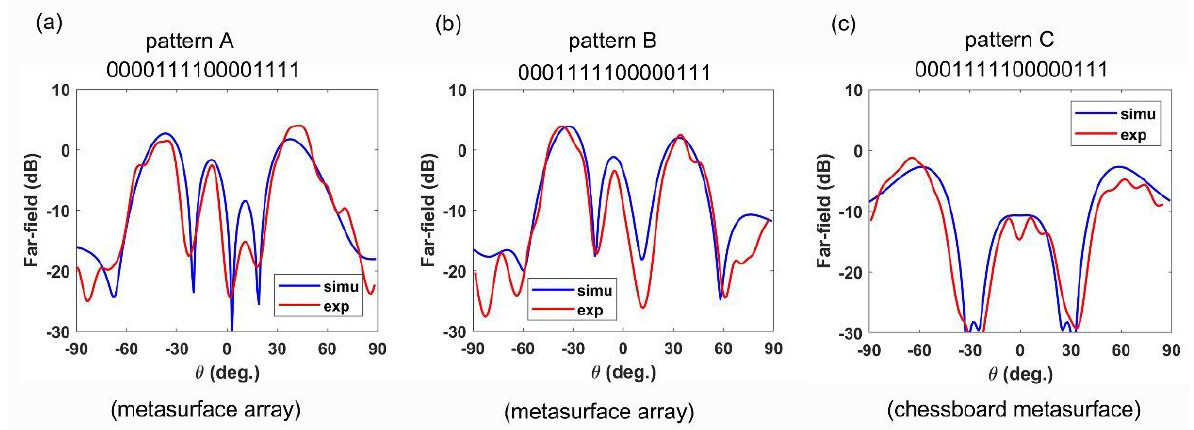
Figure 6. The far-field experimental results of three patterns. ( a ), ( b ), and ( c ) present a comparison of far-field simulation and the experimental results of patterns A, B, and C, respectively.